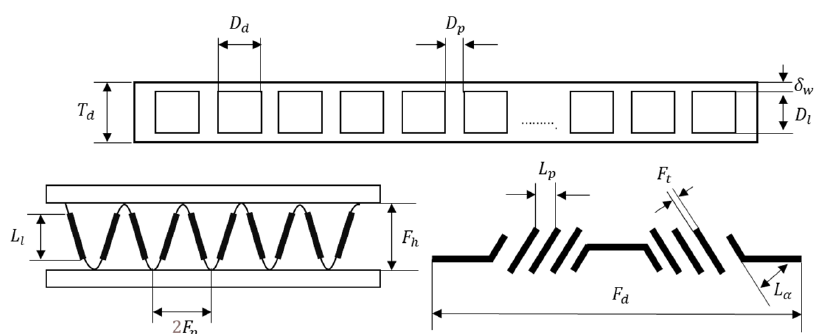
Figure 1. Microchannel heat exchanger and a cross-section view of the flat tubes.